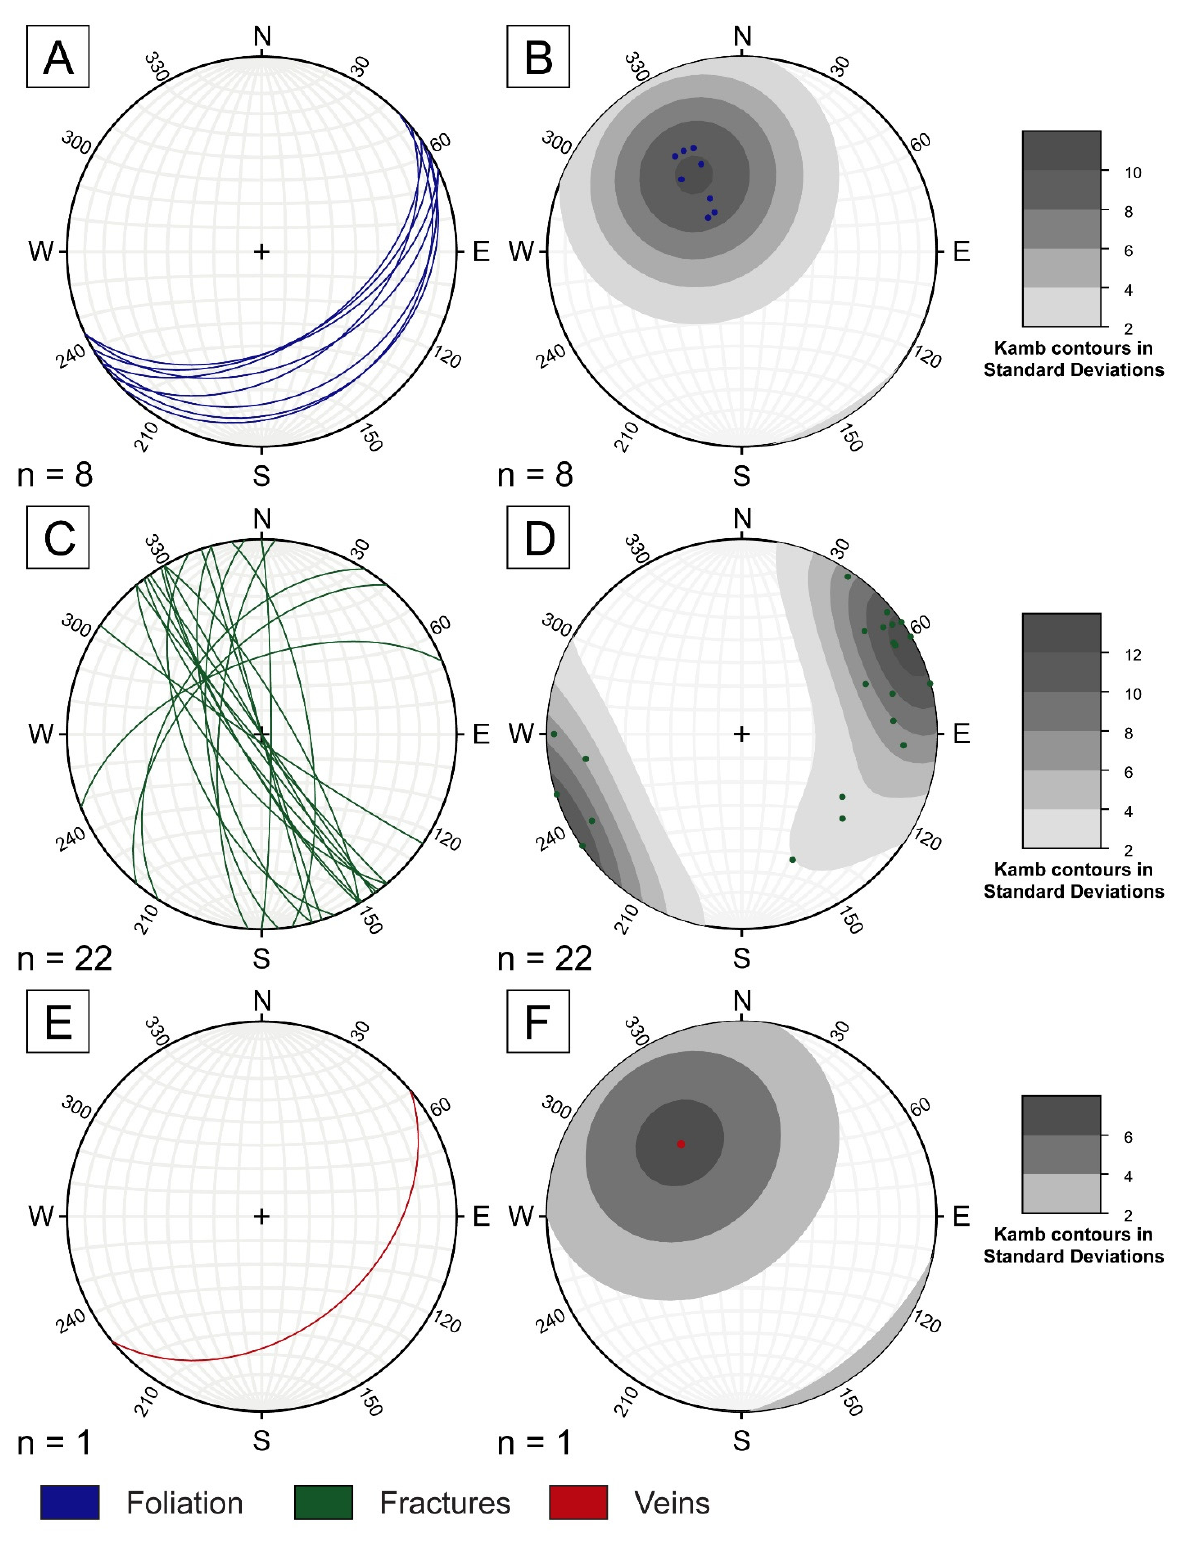
Figure 11. Planar and polar (pole-to-plane) plots with density contours of structures in the Bedrock Creek area (field and drillhole data). ( A , B ) foliation; ( C , D ) fractures; ( E , F ) veins.